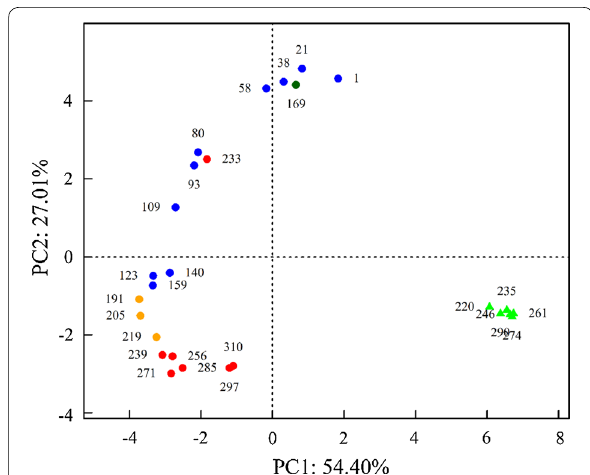
Fig. 3 Principal Coordinates Analysis (PCoA) based on Bray–Curtis distance from bacterial 16S rRNA gene sequences. Samples were simply represented by the numbers showing the sampling dates. Triangles: samples from SHARON reactor. Circles: samples from ANAMMOX reactor. Blue: samples obtained with influent load